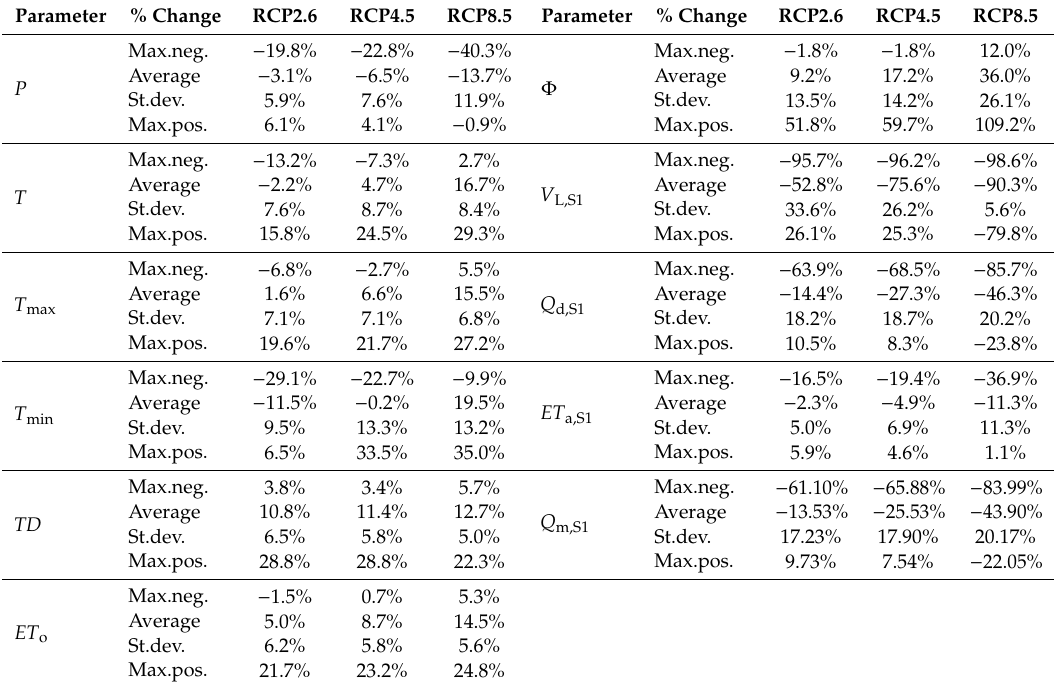
Table 3. Maximum negative, average, standard deviation and maximum positive % of changes in mean annual values of P , T , T max , T min , TD , ET o , Φ , V L,S1 , Q d,S1, ET a,S1 and Q m,S1 estimated based on the GCMs for RCP2.6, RCP4.5, RCP8.5 in comparison to the respective mean annual values of the